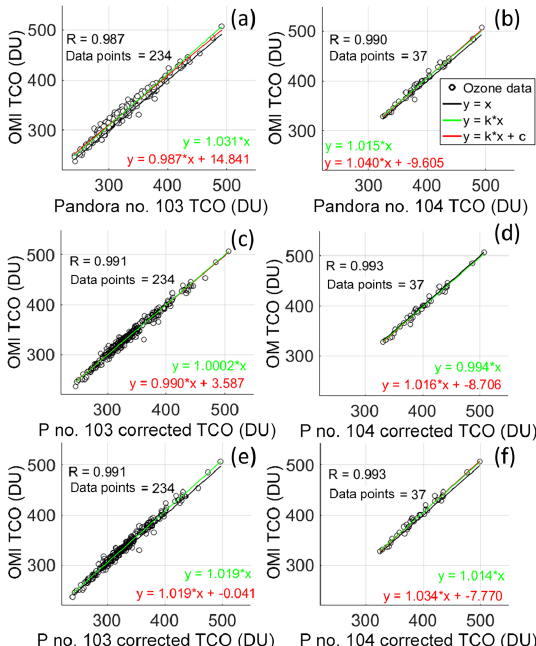
Figure 12. Scatter plots of OMI TCO vs. Pandora TCO for (a) Pan- dora no. 103 without TCO correction, (b) Pandora no. 104 without TCO correction, (c) Pandora no. 103 with correction using Eq. (11), (d) Pandora no. 104 with correction using Eq. (12), (e) Pandora no. 103 with correction using Eq. (13), and (f) Pandora no. 104 with correction using Eq.